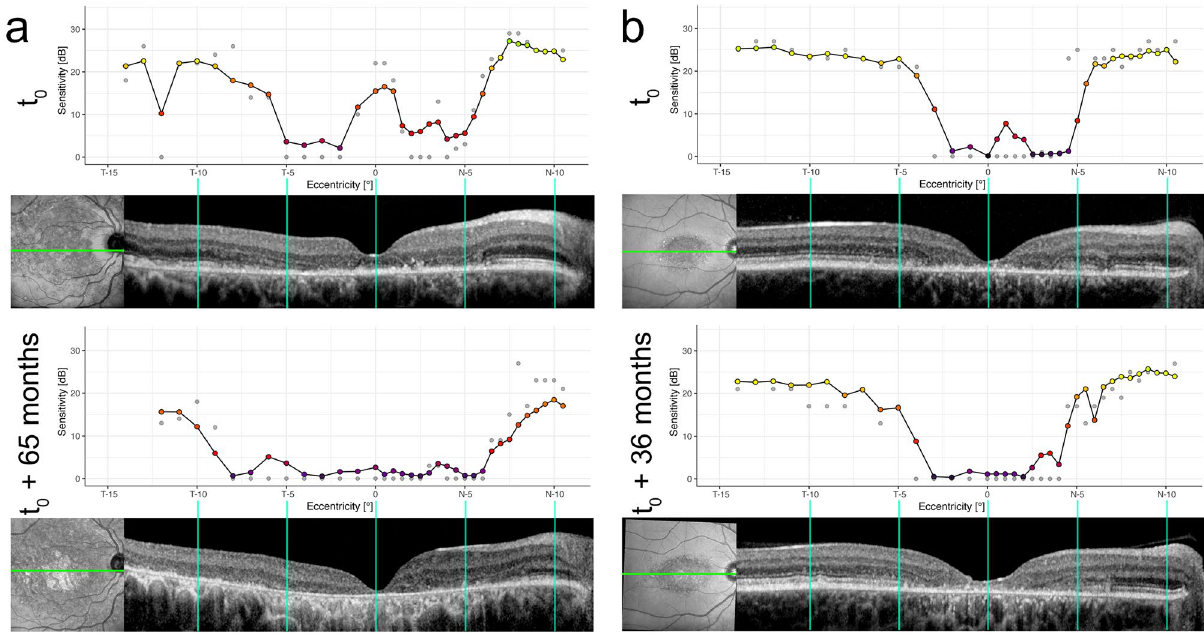
Figure 5. Prediction accuracy of sensitivity-loss over time. The predicted (grey points) and observed (color coded) fundus controled perimetry results (in decibels, dB, top), and corresponding horizontal optical coherence tomography (OCT) B-scan of two exemplary patients are longitudinally demonstrated. The green line on the infrared reflectance image indicates the approximate location of the respective OCT B-scan. ( a ) The functional consequence of the loss of foveal non-involvement over time is adequately recognized by the imaging feature based model. Also the growth of outer retinal atrophy is represented by a loss of observed as well as predicted retinal sensitivity in the first patient. ( b ) The second patient exhibits a more diffuse foveal involving retinal thinning, which is also parallelled by a loss of observed and predicted retinal light sensitivity. In the follow-up visit (bottom row), the development of a small spot of outer retinal atrophy (e.g., at approximately N-7) with loss of retinal sensitivity could correctly be predicted. A summary of the individual longitudinal data can be found in Supplementary Fig.